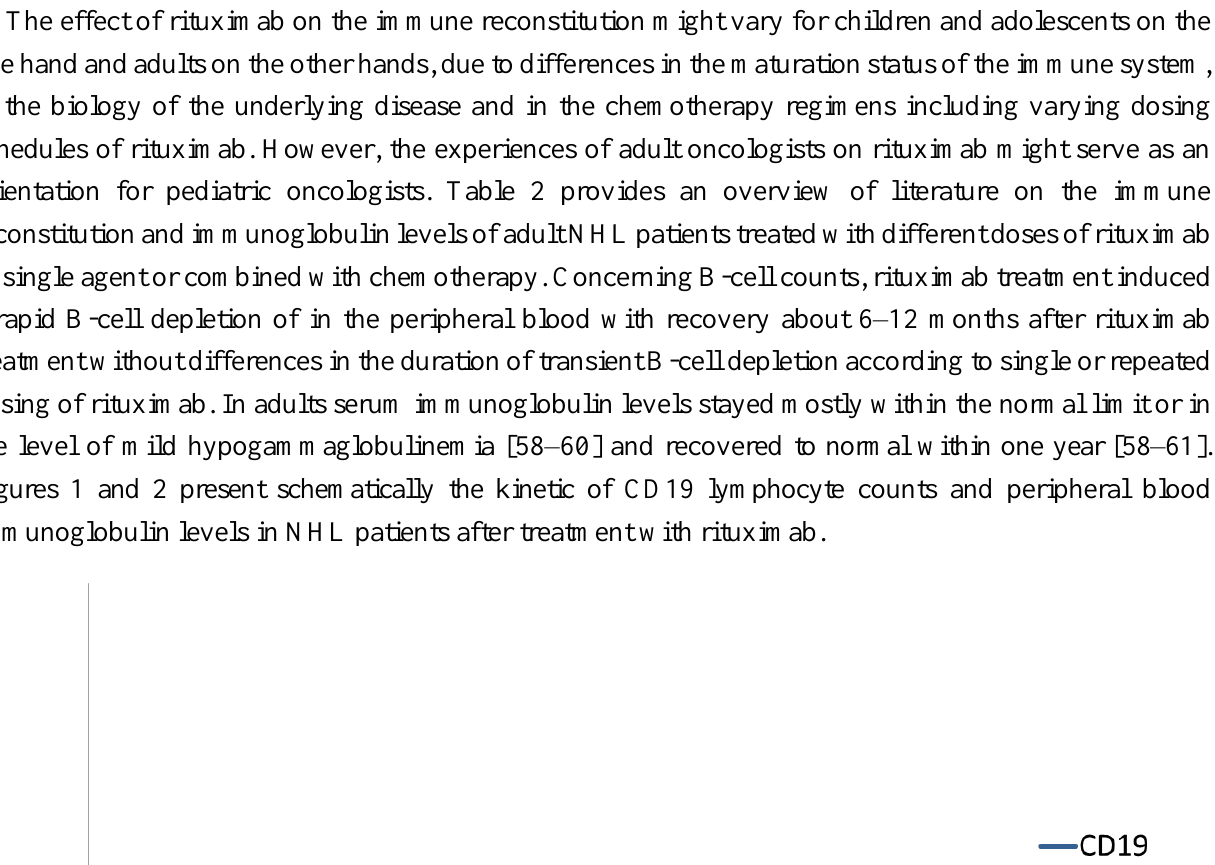
1.3. Immunereconstitution in Adult B-NHL Patients Treated with Rituximab and Chemotherapy: Lessons for the Pediatricians